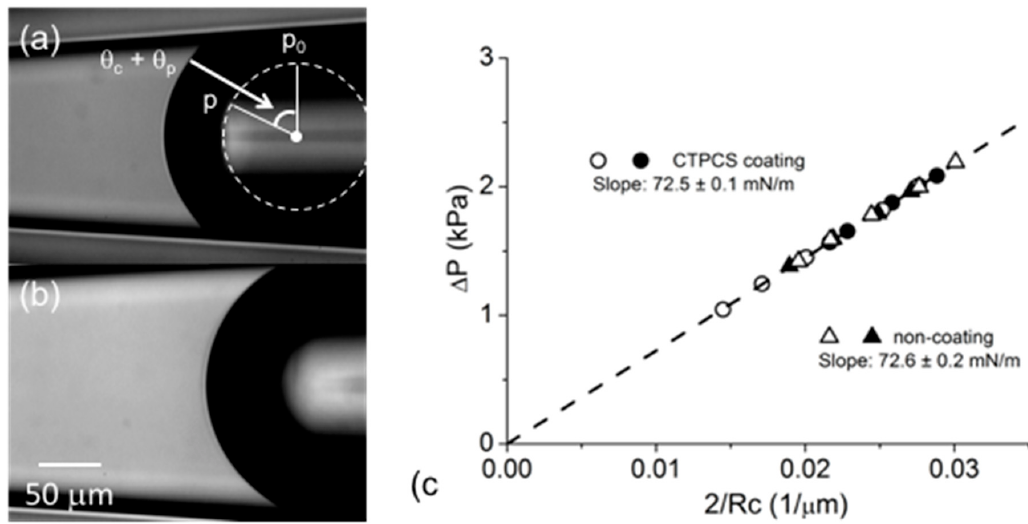
Figure 7. Contact angle change with and without silane coating at the glass surface of the micropipette at 20 ◦ C and corresponding surface tension plot. ( a ) 3-Cyanopropyltrichloro silane (CTPCS) coated micropipette, having a contact angle of 54 ◦ and applied pressure of ~1.4 kPa inside the pipette. Using the fitting of curvature (dashed circle) at the diffraction pattern at the air surface area, the contact angle is calculated by considering the point “p” and “p 0 ” giving 54 ± 7 ◦ . Note this circle is not at the interface but at the point at which the meniscus leaves the glass surface. Point “p” shows the grey and black pattern boundary spot on the circle, and p 0 shows a crossing point of the circle and a vertical line crossing the circle centre. ( b ) Non-silane coated (just glass) micropipette having ~1.4 kPa applied pressure inside the pipette with the much smaller contact angle of 5 ◦ . ( c ) Equilibrium air-water surface tension measured by the micropipette manipulation method with increasing pressure (hollow symbols: interfacial area decreasing) and decreasing pressure (solid symbols: interfacial area increasing) comparing with and without CTPCS coating. The surface tension was calculated from the slope of a plot of applied pressure ∆ P vs. the reciprocal radius of curvature 2/ R c at each applied pressure. With permission from Elsevier [7].